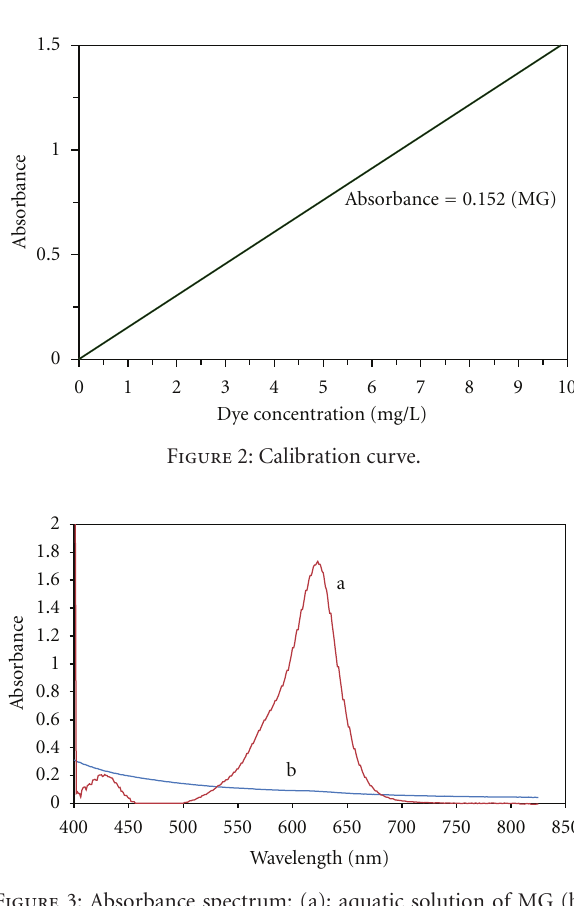
Figure 3: Absorbance spectrum: (a); aquatic solution of MG (b); aquatic solution of glucose, glucose oxidase and Fe 2+